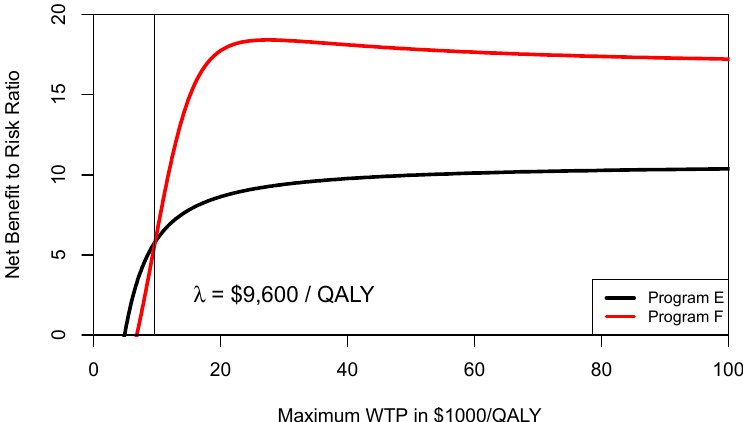
Figure 3. Cost-effectiveness risk-aversion curve (CERAC). At a ceiling ratio of $9600 per QALY, program F becomes preferable to program E (Table 1) as it offers more expected return per unit of downside